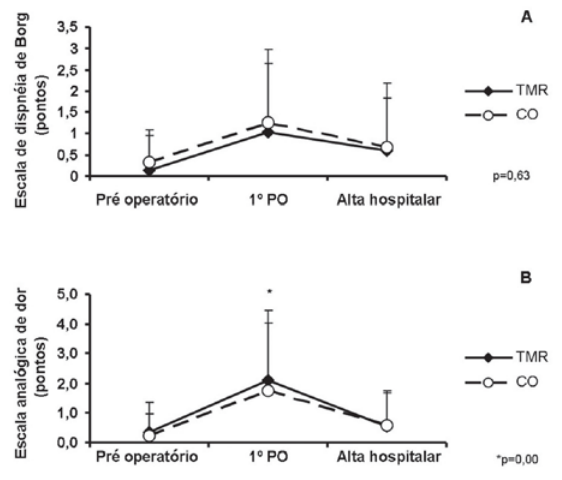
Fig. 3 - (A) Escala de dispneia de Borg (em pontos) aplicada aos dois grupos em três momentos: pré-operatório, primeiro dia de pós-operatório (1º PO) e momento da alta hospitalar; (B) Escala visual analógica de dor aplicada aos dois grupos em três momentos: pré-operatório, primeiro dia de pós-operatório (1º PO) e momento da alta hospitalar. CO = grupo controle; TMR = grupo treinamento muscular respiratório; *1º PO vs. pré-